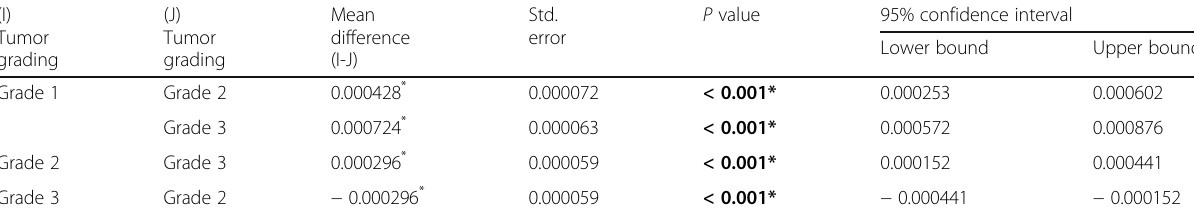
Table 8 Multiple comparisons between mean ADC value of different tumor grades (I) Tumor